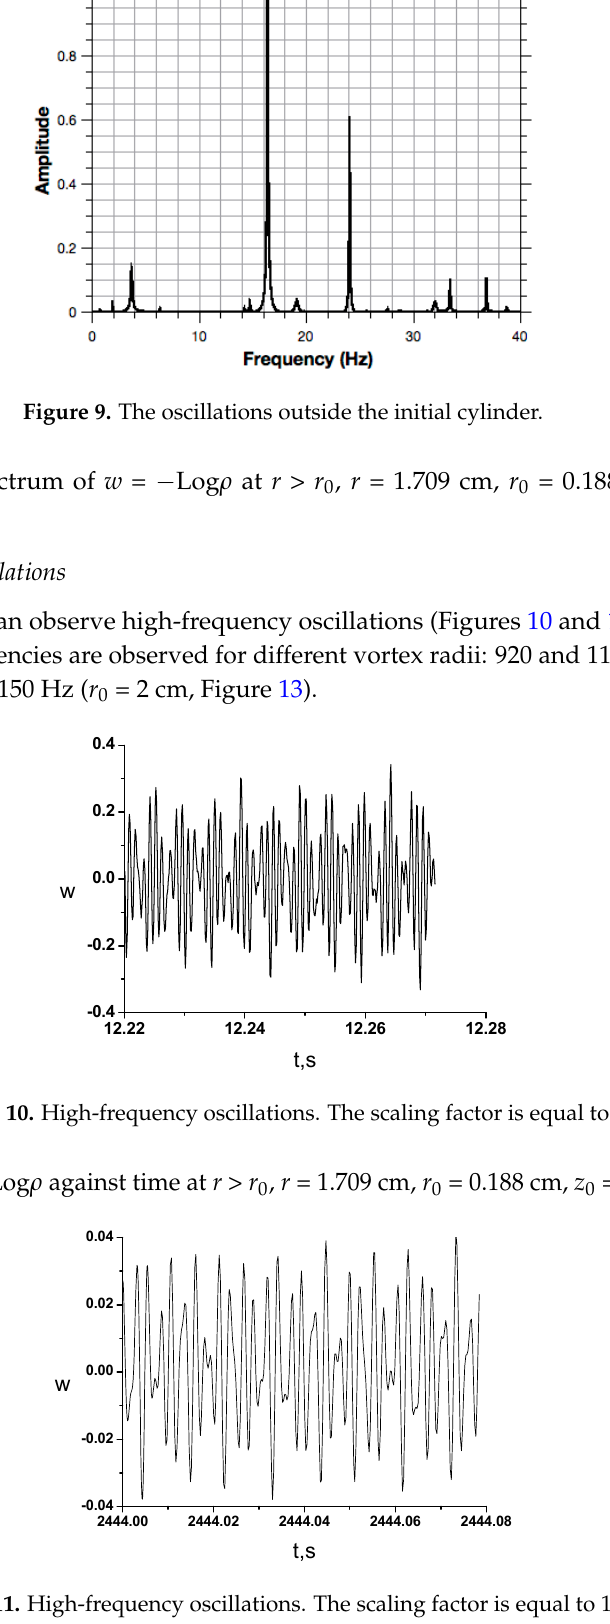
Figure 12. High-frequency oscillations. The scaling factor is equal to 1. The oscillation spectrum of w = − Log  at r > r 0 , r = 1.709 cm, r 0 = 0.188 cm, z 0 = 2.909 cm, z = 1.7 cm. Figure 13. High-frequency oscillations. The scaling factor is equal to 10.6. The oscillation spectrum of w = − Log  at r > r 0 , r = 18.12 cm, r 0 = 2 cm, z 0 = 30.84 cm, z = 18.02 cm. It is important to note that the high-frequency oscillations as well as the low-frequency ones have two natural frequencies. The occurrence of two-period oscillations can be explained by two characteristic sizes (radius and height) of the cylinder.